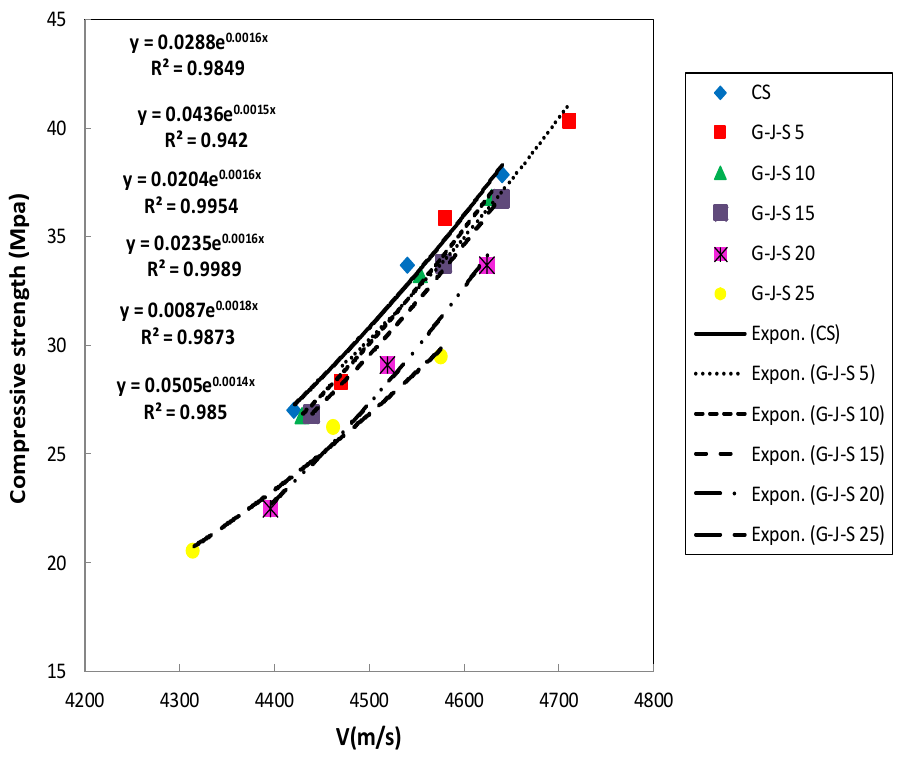
Figure 18. Relationship between UPV and compressive strength in the G-J-S group.